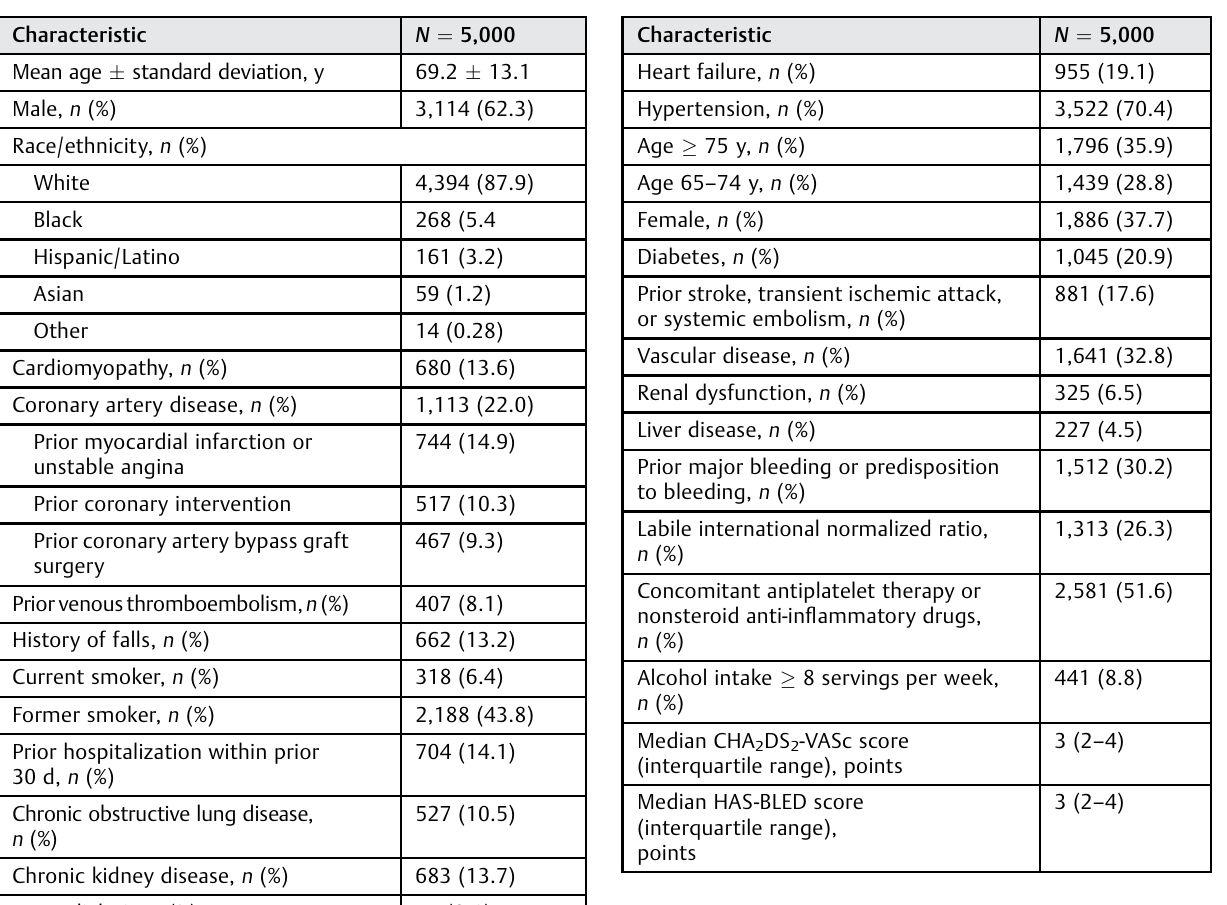
Table 2 Assessment of stroke and bleeding